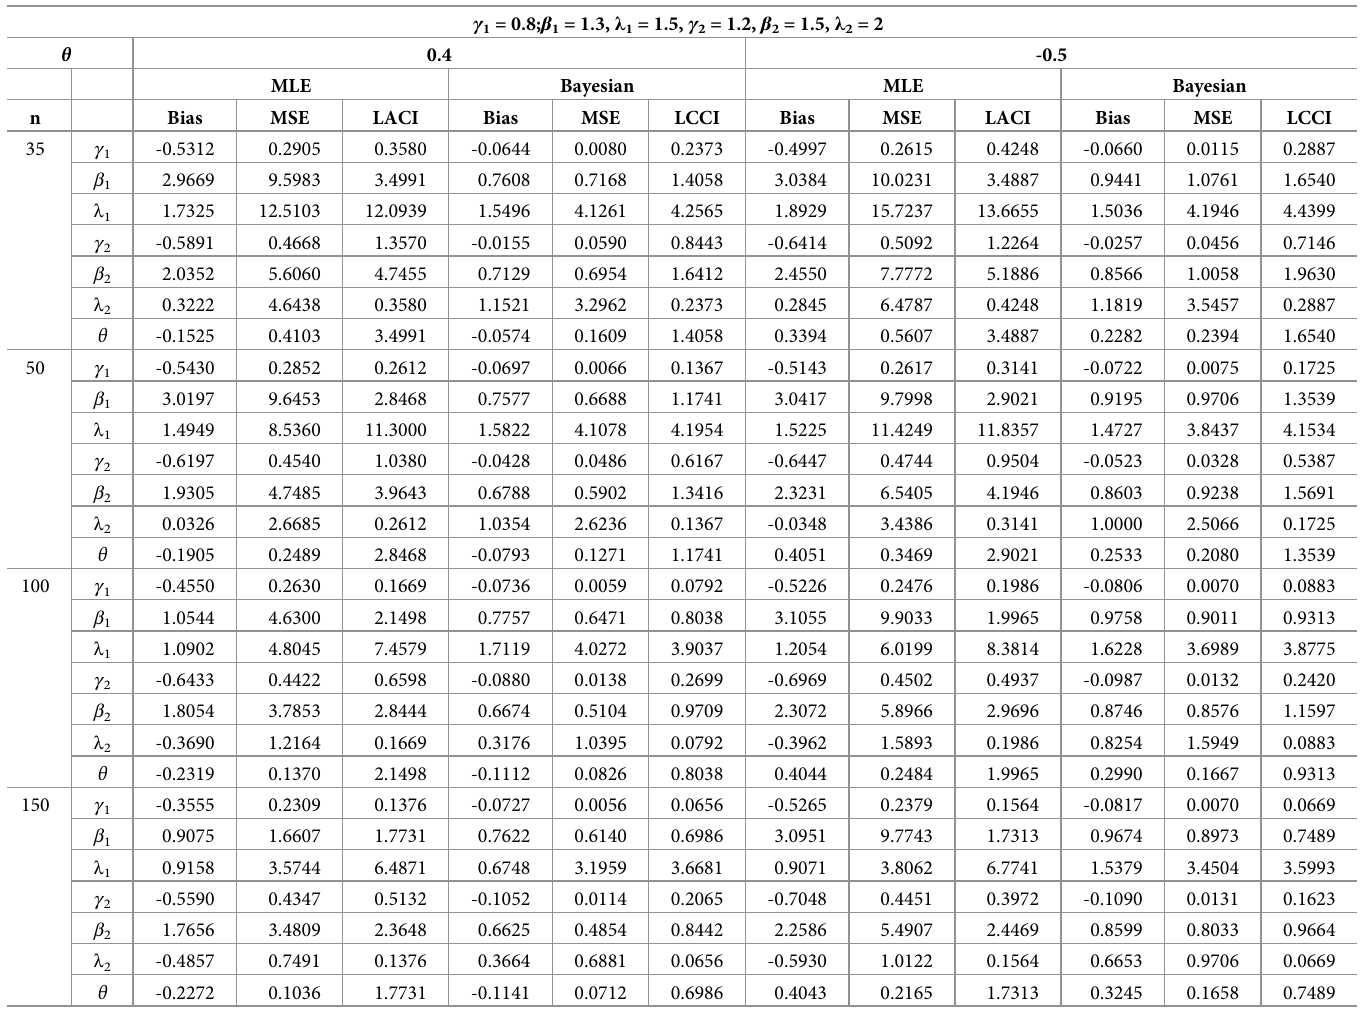
Table 3. MLE and Bayesian estimation method for BFGMPLx model parameters.